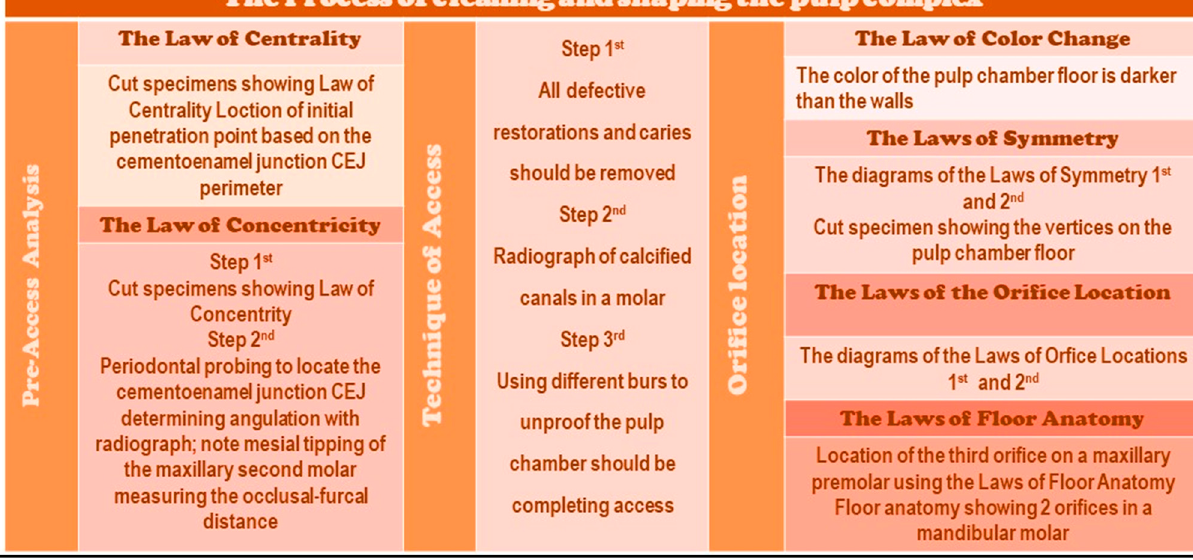
Figure 8. A set of rules and laws regarding the qualification of teeth for endodontic treatment based on the analysis of the anatomy of the treated tooth and the surrounding tissues.